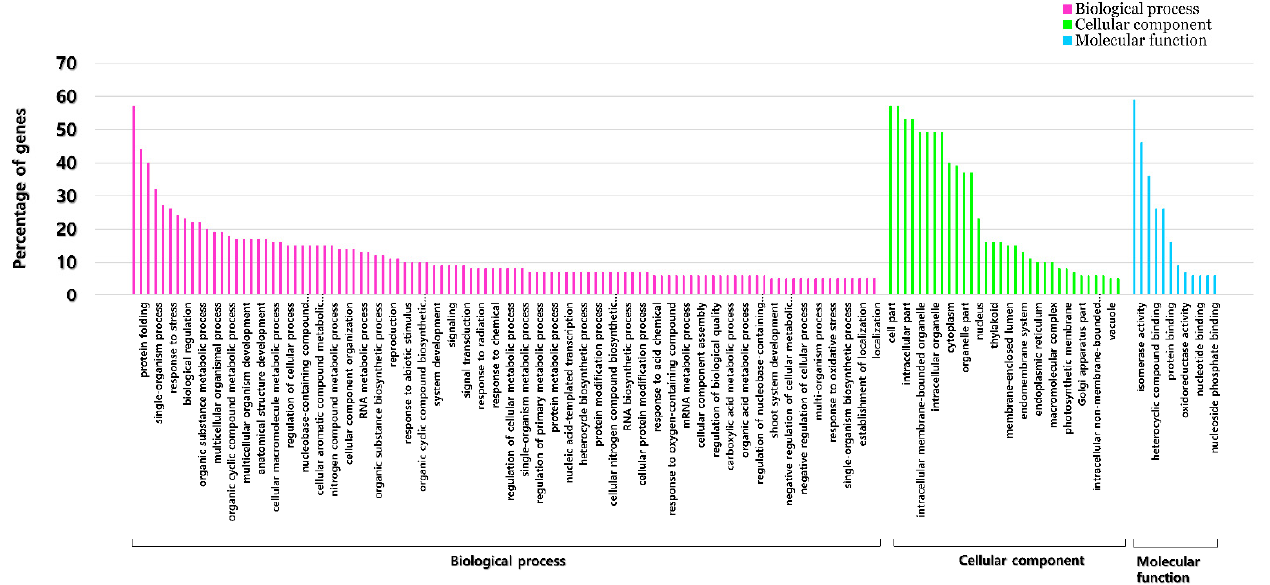
Figure 5. GO analysis of ‘Nampungchal’ genes related to cis -regulatory element.